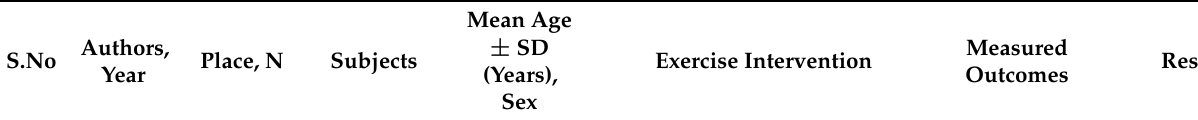
Table 1. Effect of exercise on subjects with cancer and baseline measurement of sarcopenia.